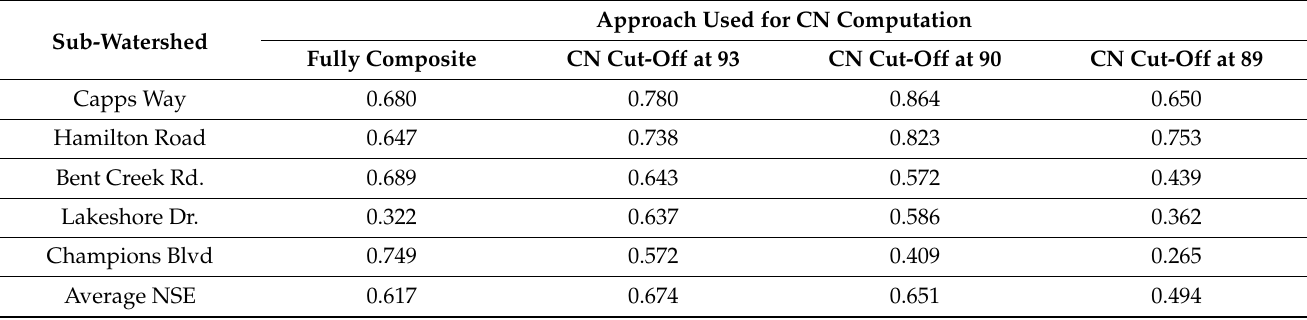
Figure 9. ( a ) Champions Blvd depth hydrograph and hyetograph with corresponding modeling results; ( b ) Detail of the depth hydrograph for the rain event on 16 January 2022. Table 5. NSE results summary for peak flow depth comparison for all studied